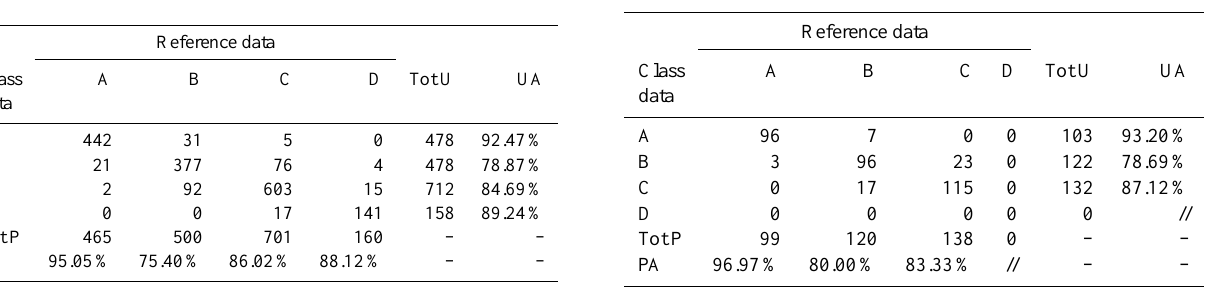
Table 7. Confusion matrix for the radial basis function network classifier evaluated on the test set TeS (cid:127) with elevation between 1300 and 1600m; Class A: absence of snow cover, Class B: 1– 10cm, Class C: 11–90cm, Class D: greater than 90cm.